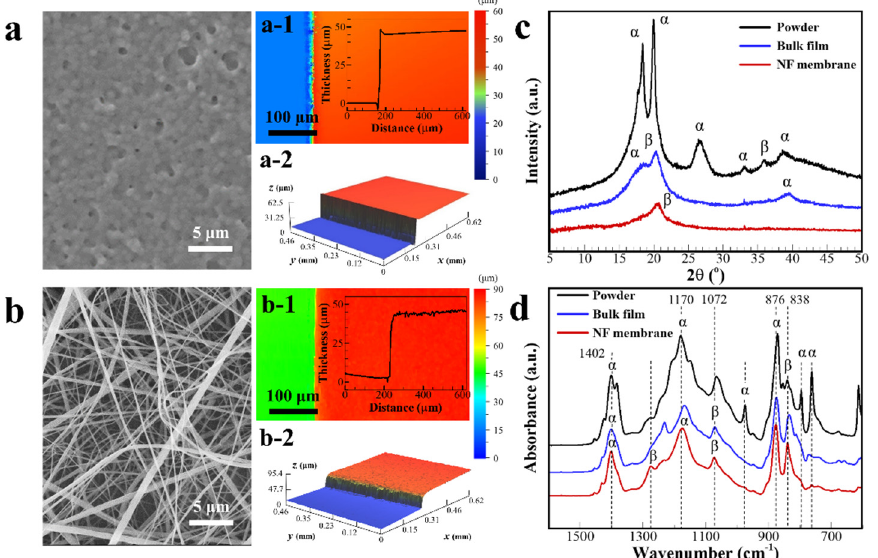
Figure 2. Surface geometry analysis of ( a ) bulk PVDF film and ( b ) electrospun PVDF NF membrane using SEM images and 3D optical analyzer. ( c , d ) XRD and FT-IR analysis results for PVDF with NF membrane, bulk film, and powder geometries.